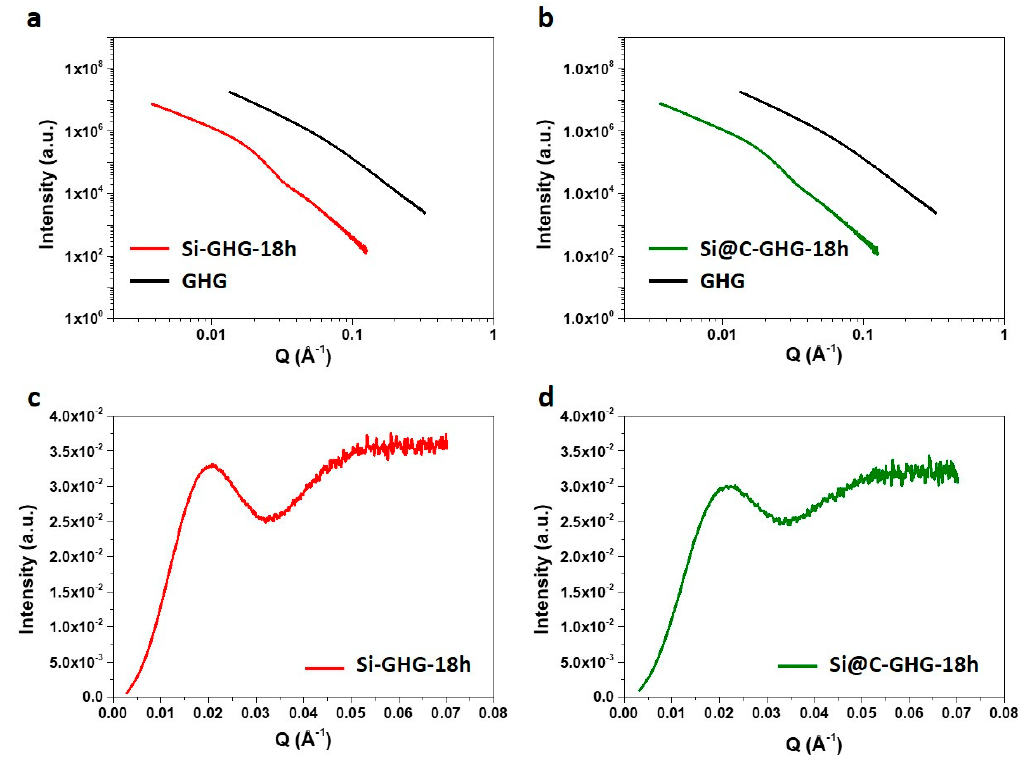
Table 1. Comparison of the various Si NPs and Si@C NPs diameters determined by either TEM, BET, or SAXS analyses.